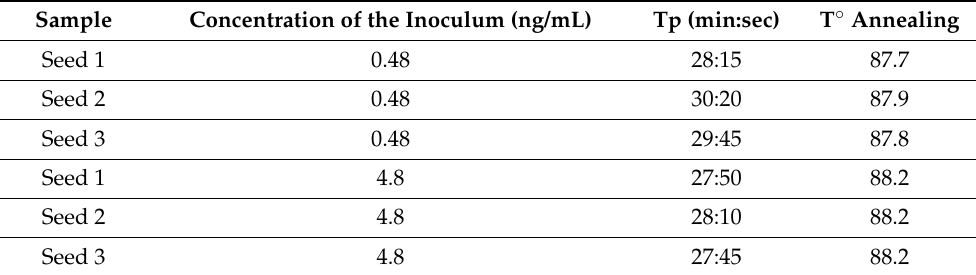
Figure 4. Analytical sensitivity of the LAMP assay obtained by the amplification of ten-fold serial dilutions of DNA of F. fujikuroi (I1.3) from a concentration of 10 ng/ µ L to 100 fg/ µ L. Table 3. Results of the analytical sensitivity limit of the LAMP assay for F. fujikuroi on artificially inoculated rice seeds cv. Dorella. The table shows Time to positive (Tp) and average annealing temperature of the three technical replicates